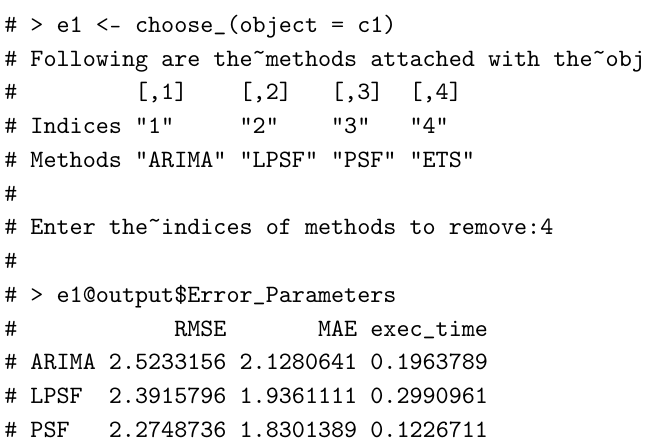
Figure 2. Forecasting errors (in bar plot) and forecasted values (in line plot) for methods attached in the object c1